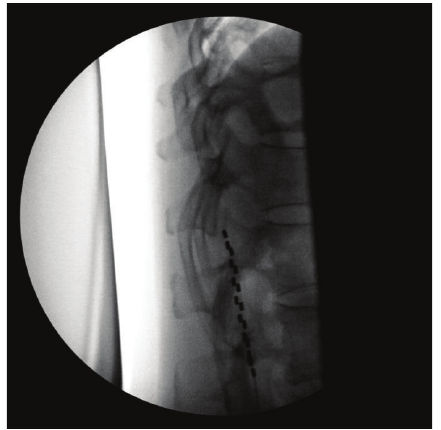
Figure 2: Lateral fluoroscopic view of SCS trial.